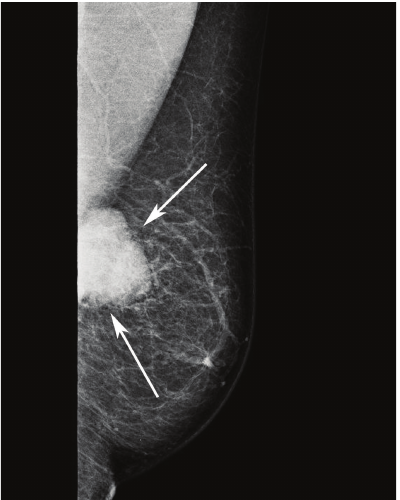
Figure 1: Lateral oblique mammography of the left breast shows smooth-bordered, big soft tissue lesion (arrows) at the upper middle quadrant.